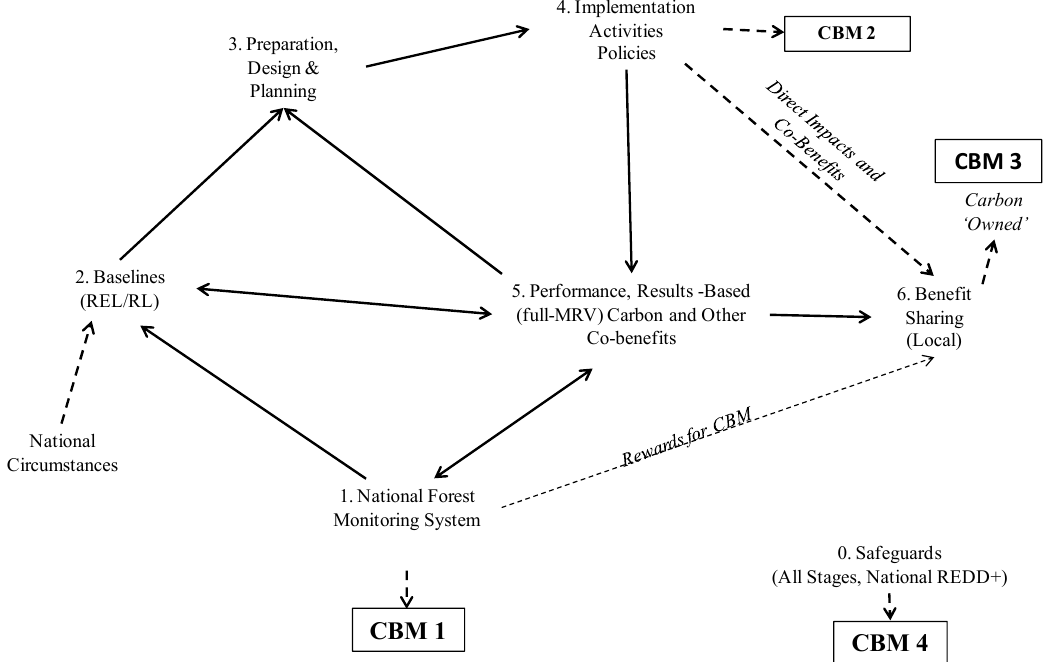
Figure 1. General Process for implementing REDD+ and opportunities for CBM; solid lines indicate the expected implementation process of REDD+; dotted lines refer to expected local benefits and options for community based monitoring